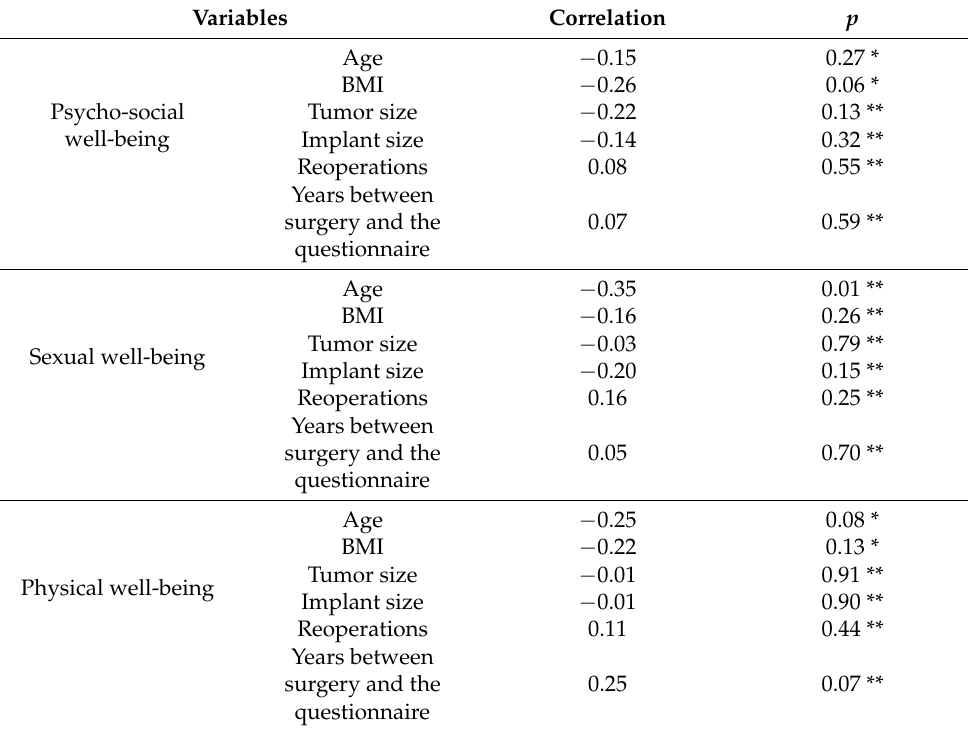
Table 6. Correlation between the score on the health-related quality of life scales and patient’s charac-